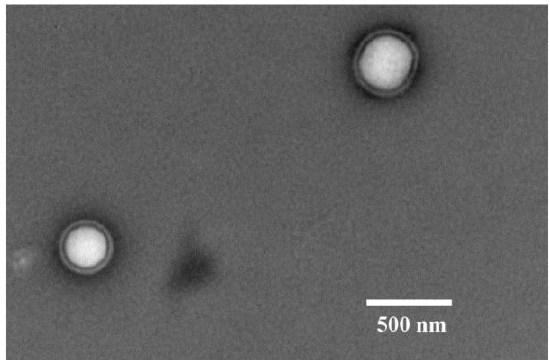
Figure 1. Transmission electron microscopy (TEM) image of the prepared Eudragit Retard L (Eudragit RL) nanoparticles (ENPs).